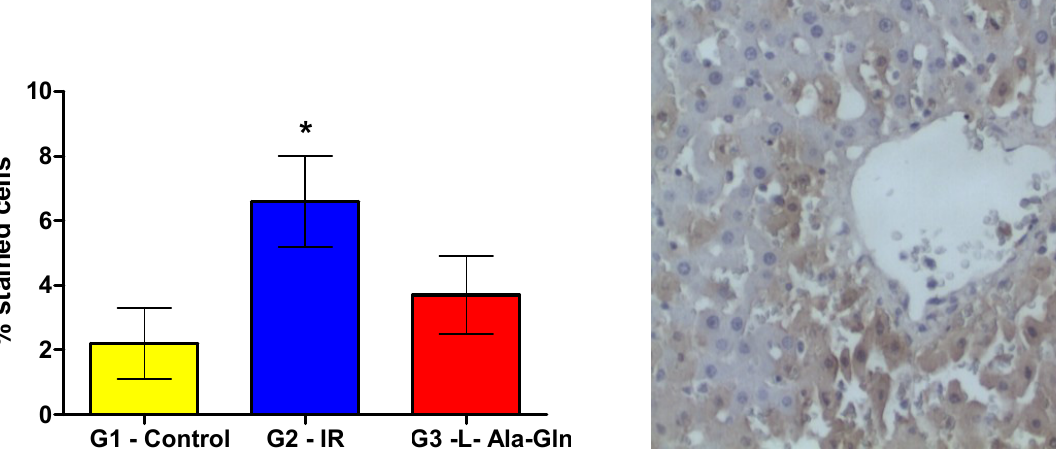
FIGURE 4 - Percentage of cells marked with caspase-3 in the liver of G-1 (Control), G-2 (Ischemia/reperfusion) and G-3 (Ischemia/ reperfusion+L-Ala-Gln) rats. Bars represent mean ± SD of G-1 (yellow bars), G-2 (blue bars) and G-3 (red bars) groups at the end of the reperfusion. G-2 group is significantly different from control group by ANOVA test. * P< 0.05 compared with control group.